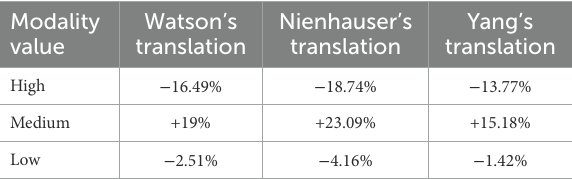
TABLE 9 The proportion of modality value shifts in the three